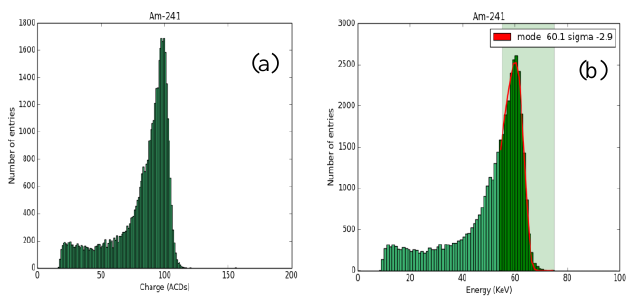
Fig. 7 . Theoretical CCE for different laser penetrations and measure CCE for a MIPs .